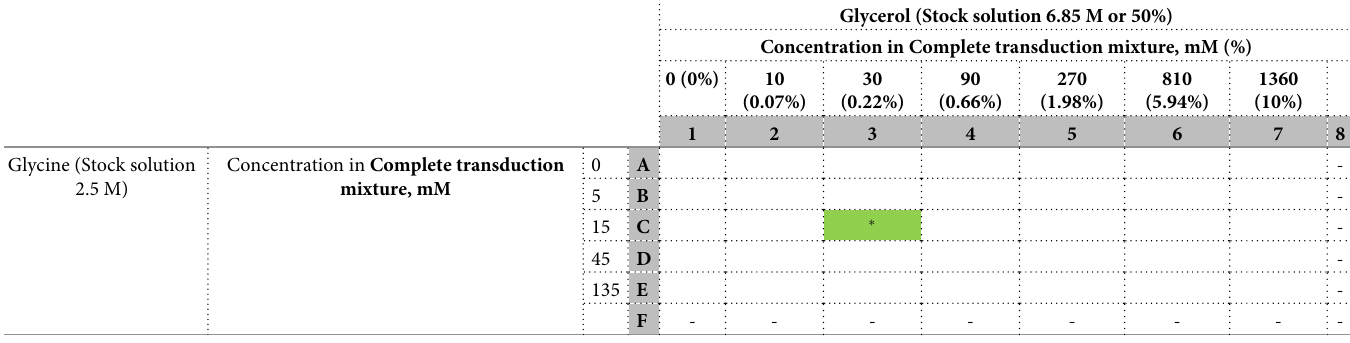
Table 4. Osmoprotectants concentrations optimization during iTOP protein transduction (48-well transduction plate layout).